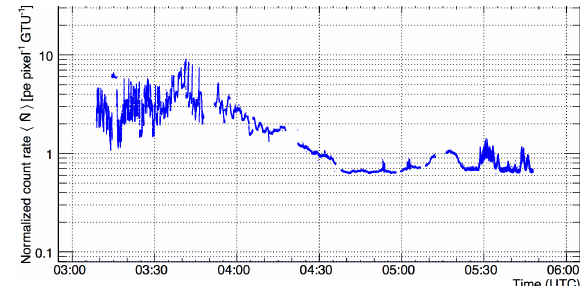
Figure 4. Average normalized count rates (cid:104) ˆ N (cid:105) as a function of the packet time [15].